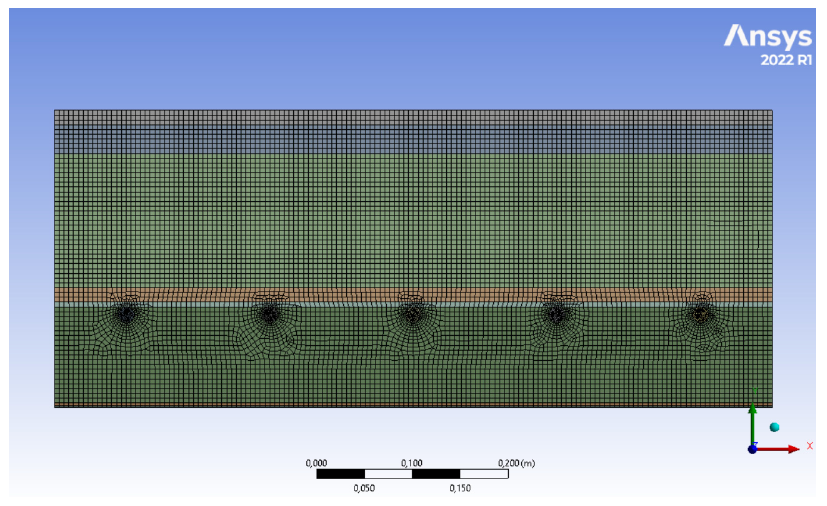
Figure 7. The procedure for solving a computer simulation in ANSYS.